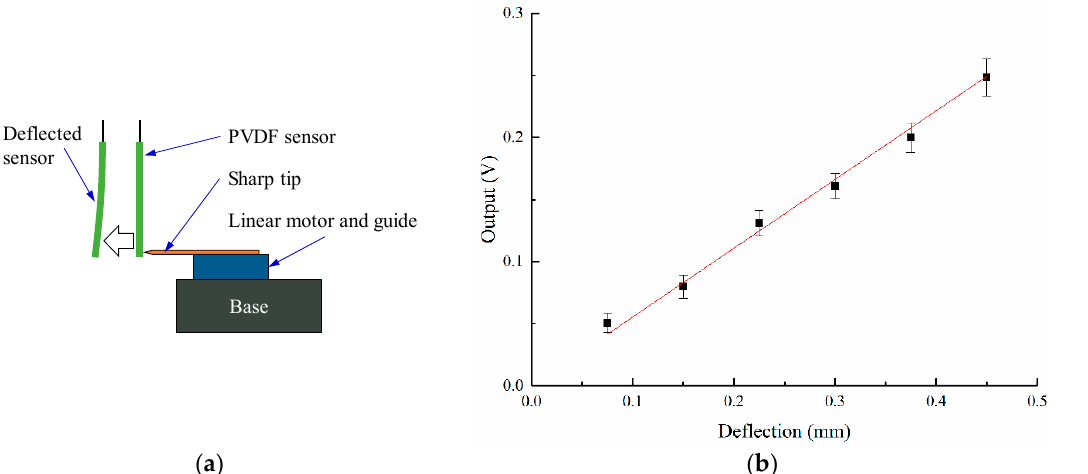
Figure 4. Calibration of the deflection-voltage relationship of the monitoring system. ( a ) Calibration setup; and ( b ) calibration results.